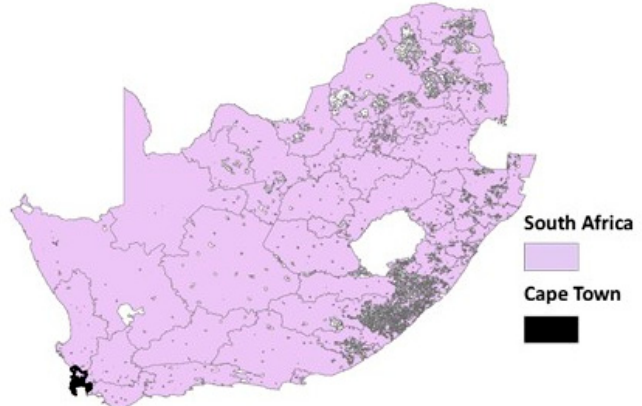
Figure 1. Location of Cape Town relative to South Africa .